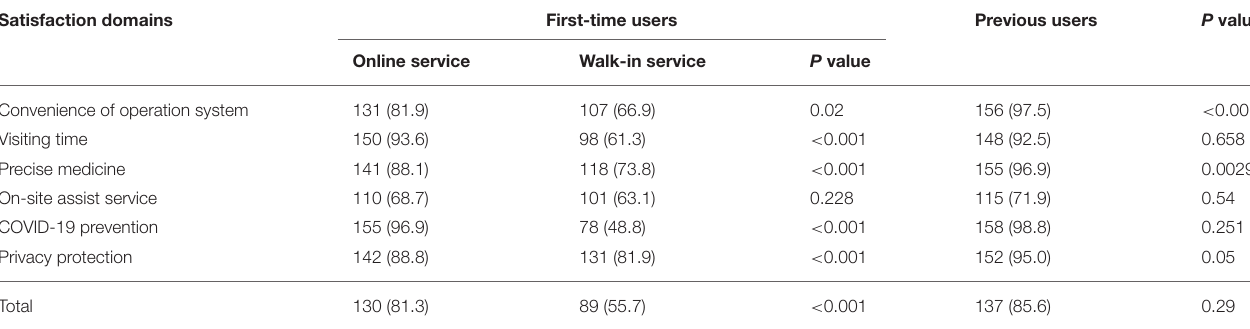
TABLE 2 | The satisfaction of respondents with internet-based appointment